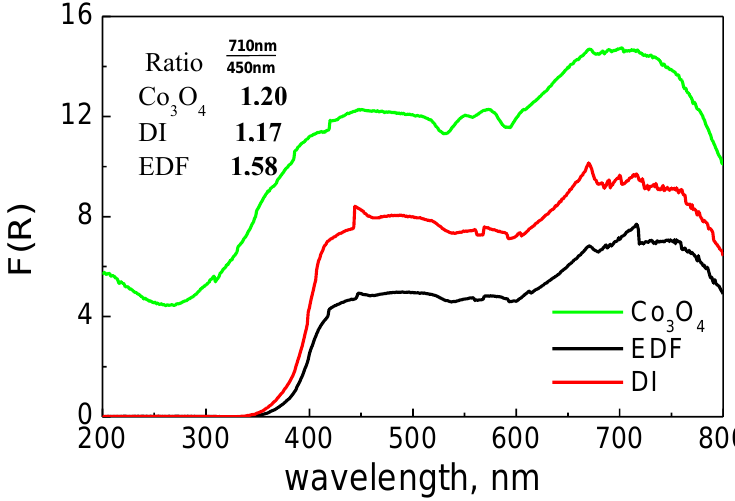
Figure 4. Diffuse reflectance (DR) spectra of the calcined samples.